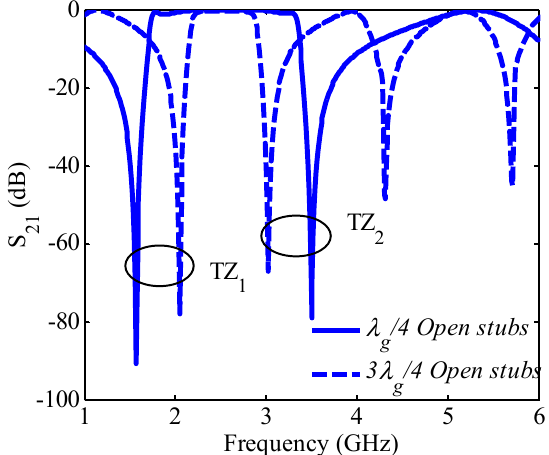
Figure 5. Simulated S 21 comparison between length λ g / 4 open-ended stubs and length 3 λ g / 4 open-ended stubs.